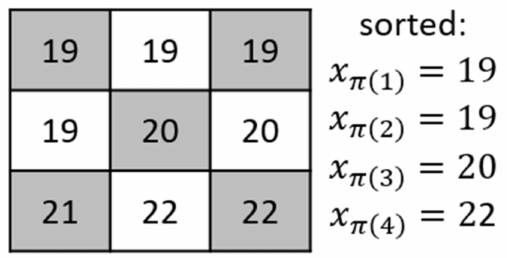
Figure 3. Sorted pixel